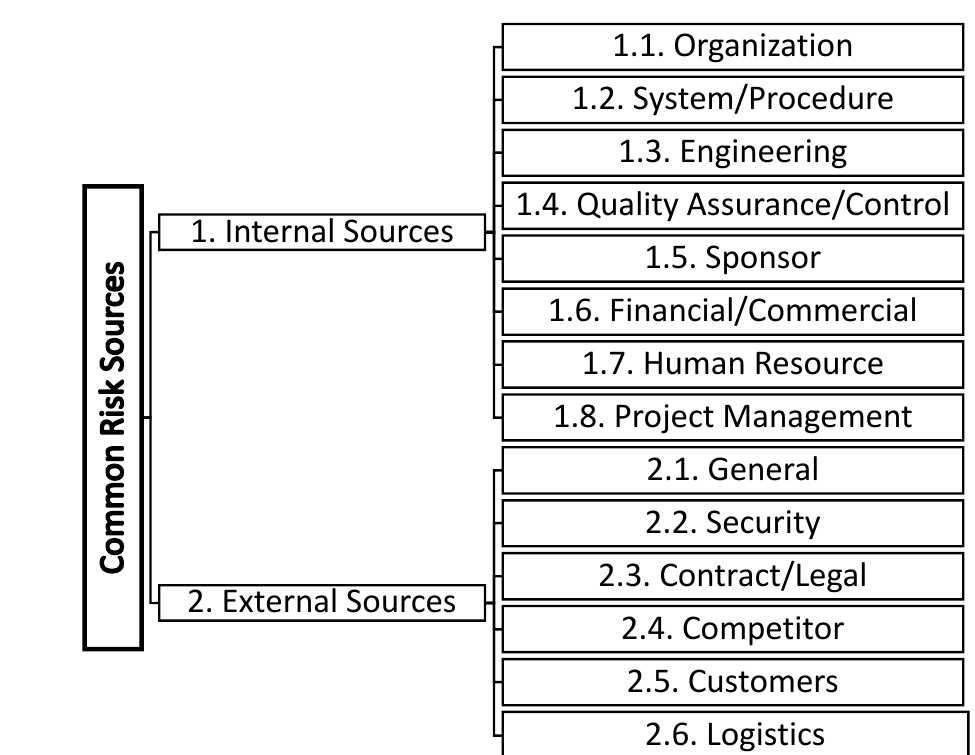
Fig. 1: Common Risk Sources and their Classification Table 2: Number Of Generic